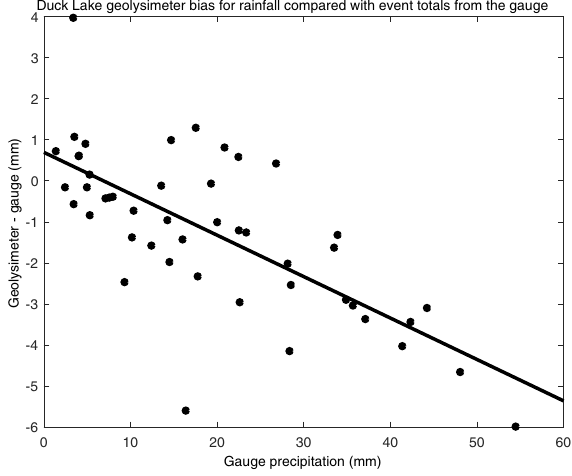
Figure 4. Relationship between the bias in geolysimeter rainfall measurements and total event rainfall amount as measured by the gauge at Duck Lake ( r 2 = 0.51).